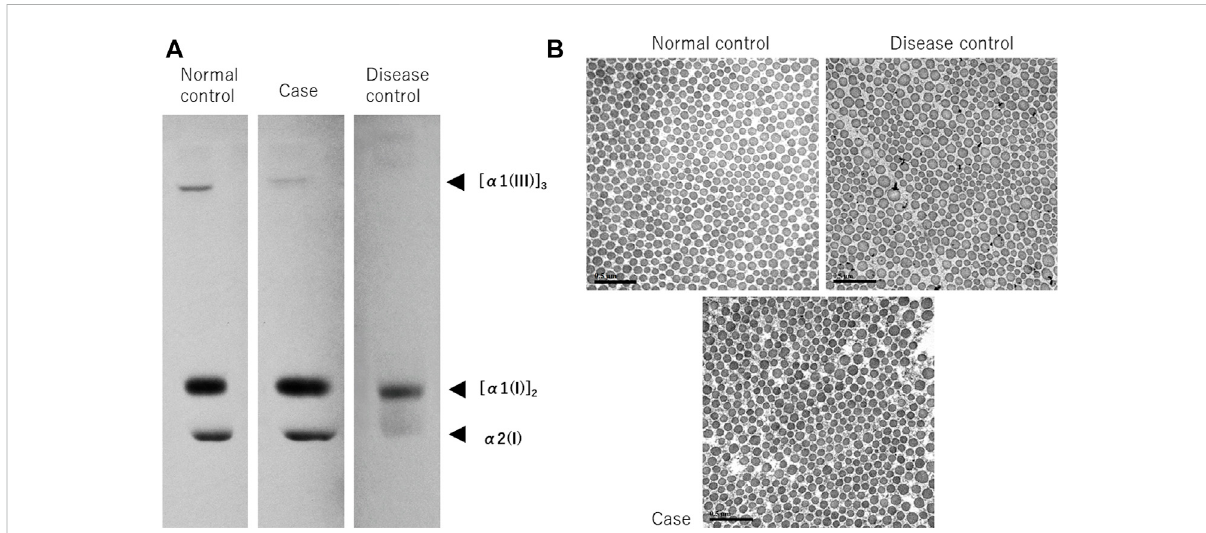
FIGURE 3 Synthetic analysis of procollagen and electron microscopy of collagenous bundles. Procollagen from cultured skin fi broblasts was electrophoresed and analyzed (A) . In the disease control, α 1 collagen III is barely visible, but in the normal control, it is apparent. Contrarily, the expression in this case ’ s sample is at an intermediate level between the normal and disease control samples, suggesting a de fi ciency in expression. Observation of collagenous bundles under TEM (B) , bar; 0.5 µm). Numerous small collagenous bundles were found in the disease control, and as a result, the size difference was conspicuous. However, the size was similar to that of the normal control. In the present case, the size difference was milder than it was in the disease control, owing to the structural abnormalities observed when compared with the normal